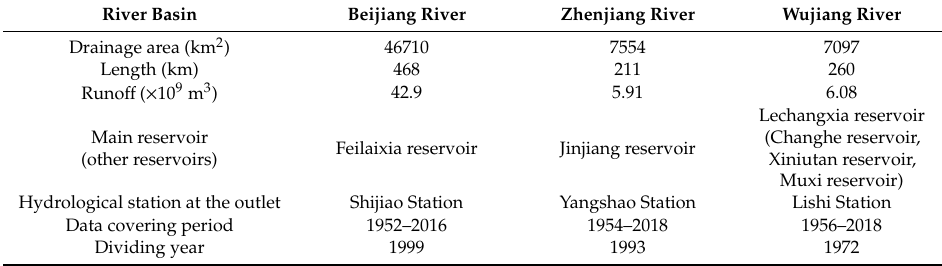
Figure 1. Locations of hydrological and meteorological stations ( a ) and reservoirs ( b ) in Beijiang River basin. Table 1. Detail information of river basins and corresponding hydrological stations and reservoirs.